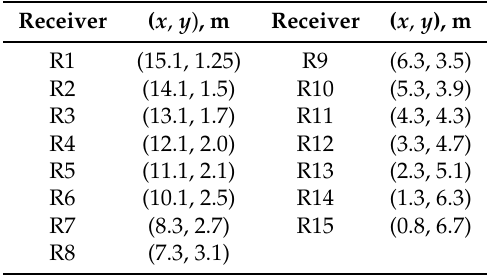
Figure 12. Source signal of fourth-order Butterworth type 1/3 octave bandpass filter with center frequency of 2 kHz: ( a ) impulse response and ( b ) frequency characteristic. Table 2. List for 15 receiver positions (R1–R15) in concert hall